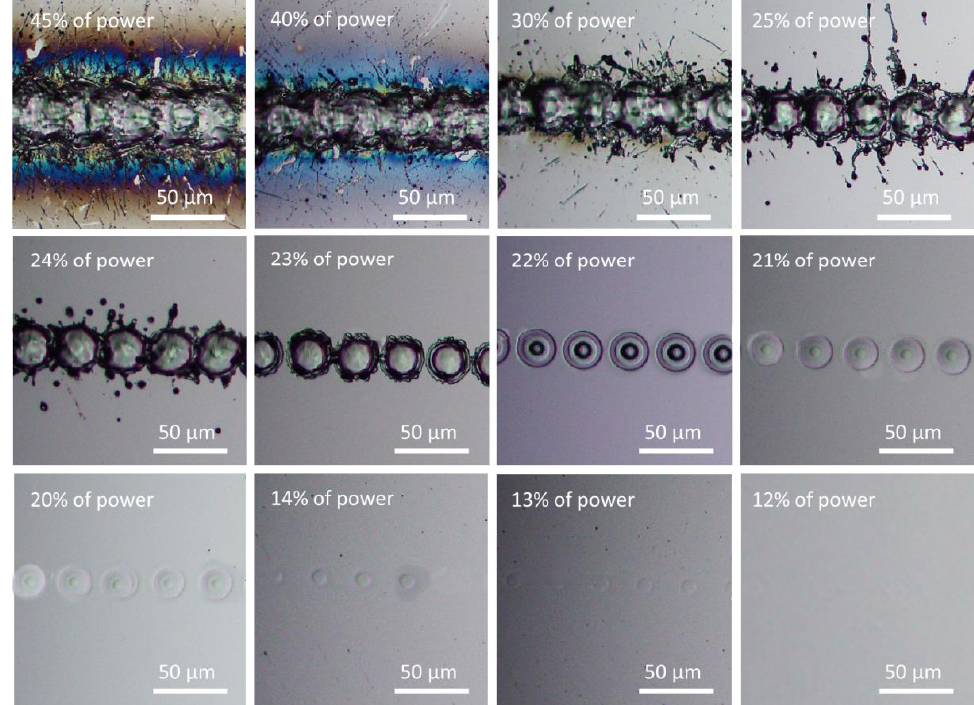
Figure 5. Surface morphologies showing surface ablation or melting under various power levels at 100 kHz and 4000 mm/s scanning speed.